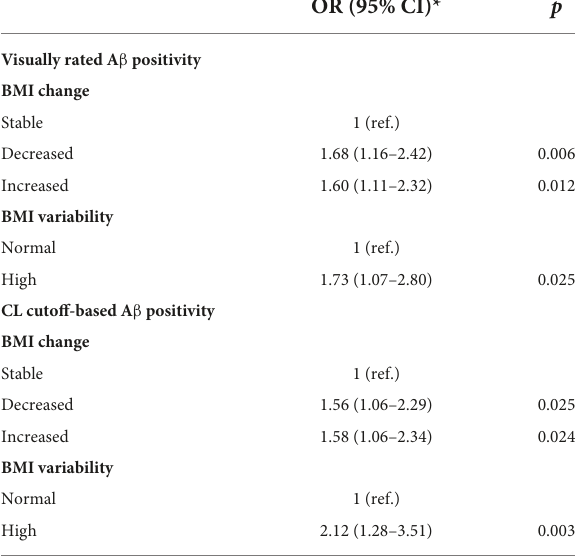
TABLE 2 Association of A β positivity with BMI change and